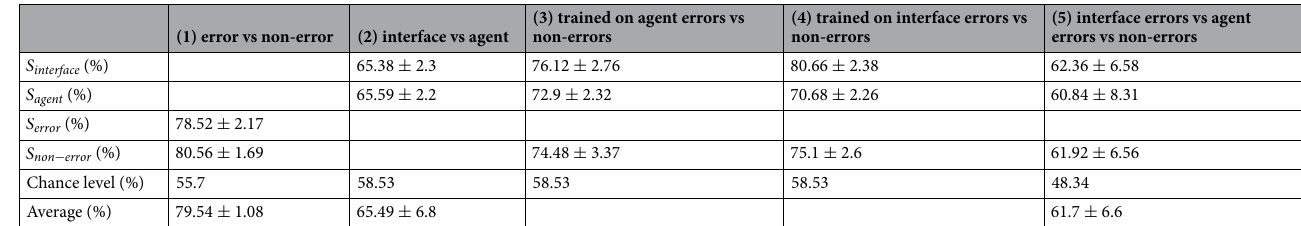
Table 4. The average of the sensitivity for each condition and each trained SVM